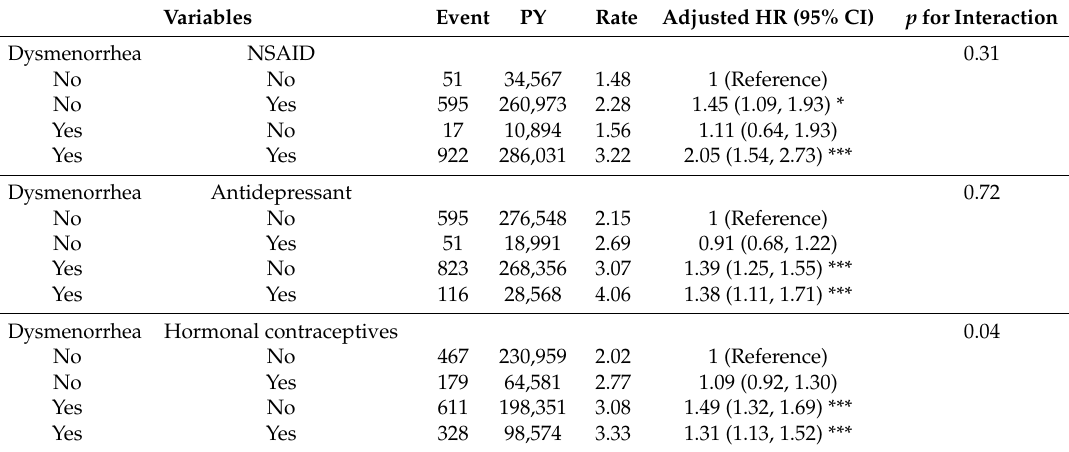
Table 4. The e ff ect of medication on the risk of fibromyalgia with or without dysmenorrhea. Variables Event PY Rate Adjusted HR (95% CI) p for